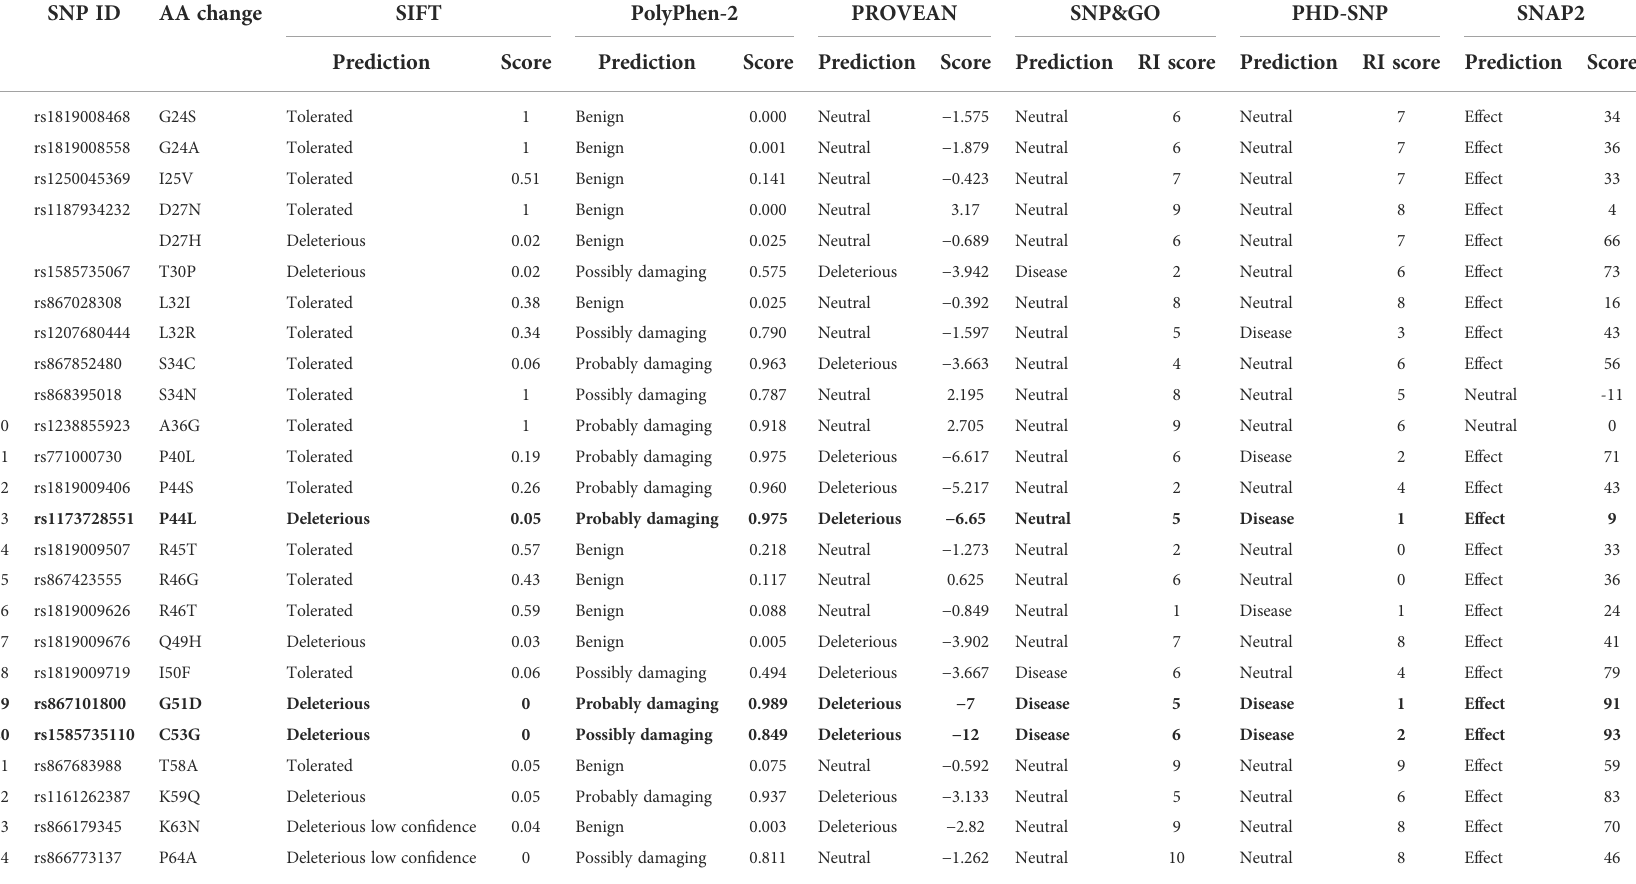
TABLE 1 Prediction and scores of deleterious missense SNPs by six in silico tools in h